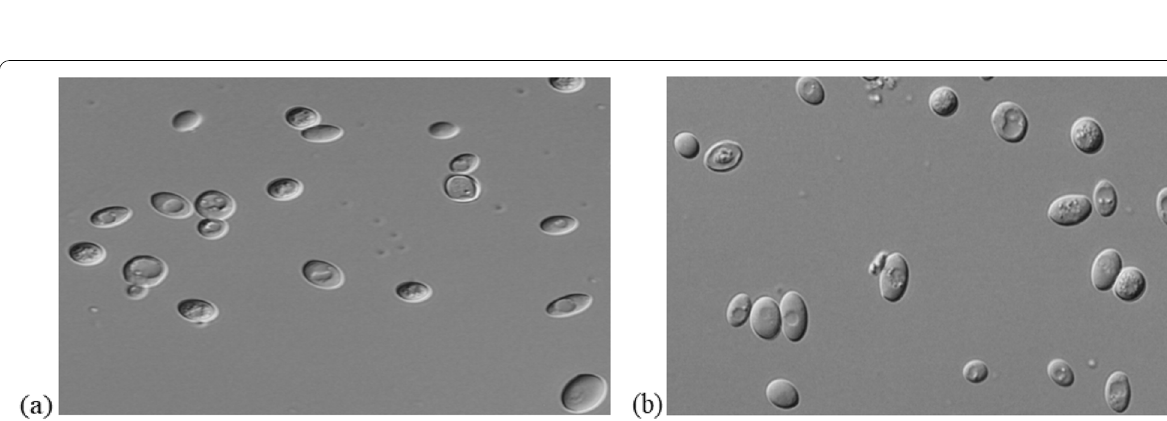
magnification with a bright field microscopy while being ×